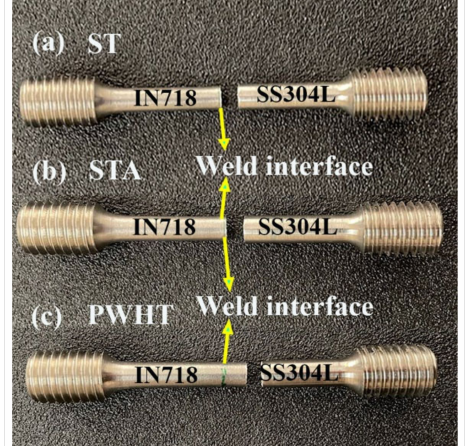
Figure 16. The failure location of the dissimilar SS304L/IN718 joints in the ( a ) as-welded ST, ( b ) as- welded STA, and ( c ) PWHT